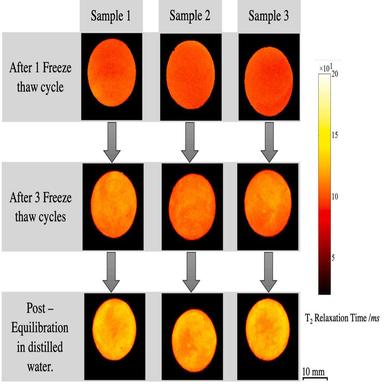
MR T2 Relaxation maps of three samples of 146–186 kDa PVA with a concentration of 10% w/w, after 1 and 3 cycles, and after 3 days of storage in distilled water to allow for equilibration.